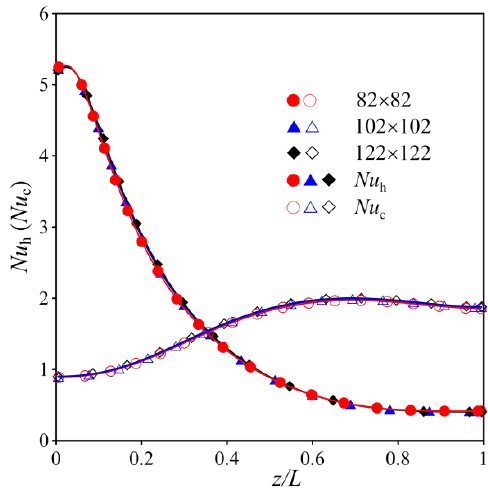
Figure 3. Grid dependence study.